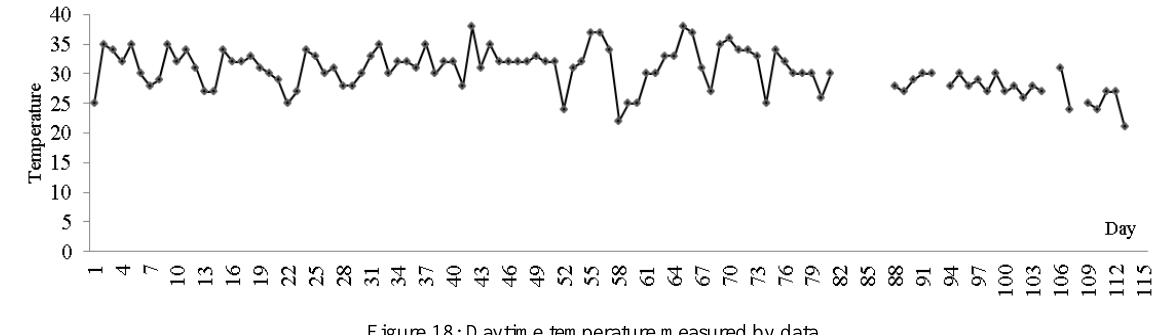
Figure 18: Daytime temperature measured by data logger